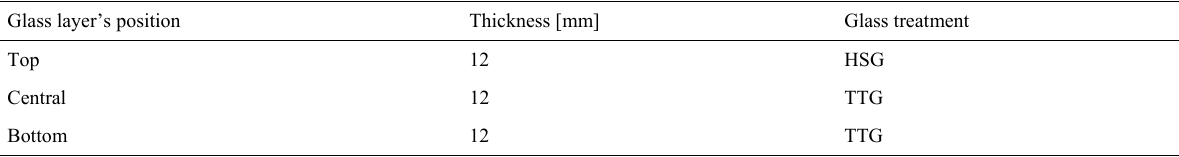
Table 3: Composition of the laminated roof glass